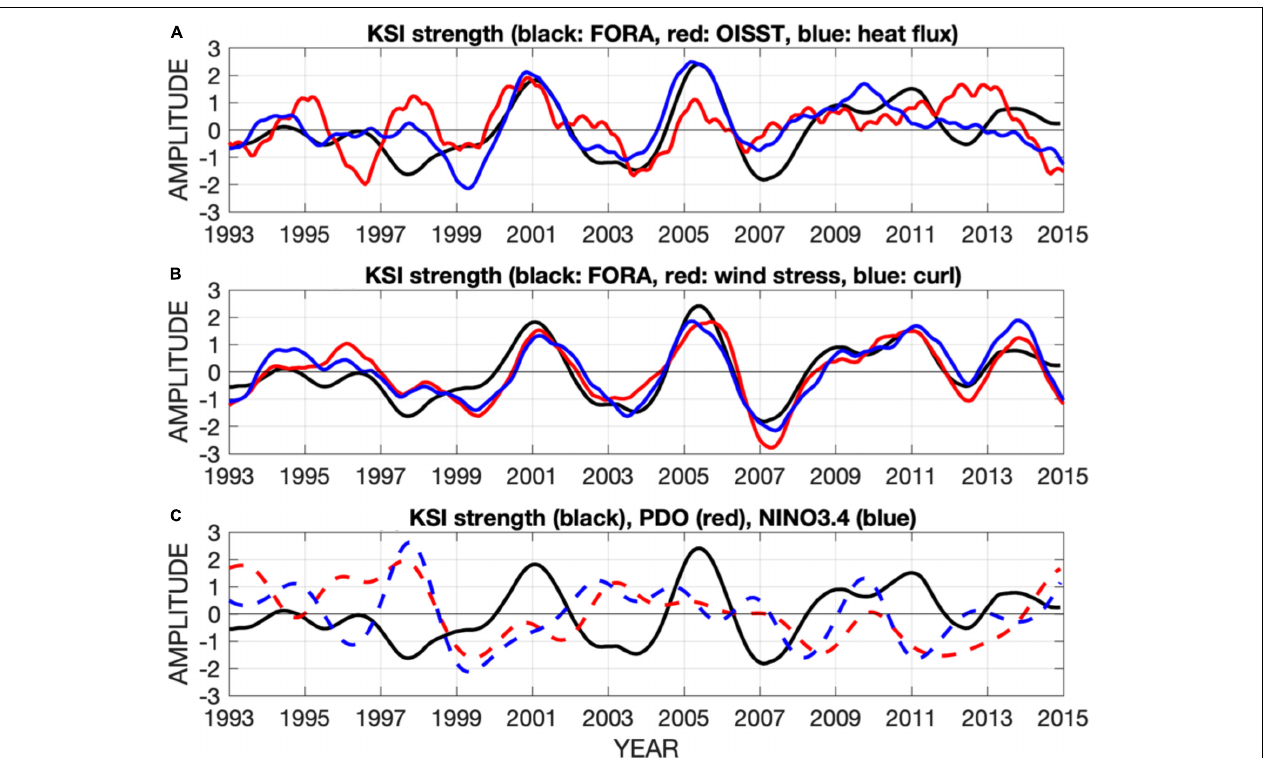
FIGURE 9 | Comparison of the temporal variability of the KSI strength mode, K _ index ( t ) (black) with (A) the regressed time series of SST (red) and surface heat flux (blue), (B) the regressed time series of wind stress (red) and wind stress curl (blue), and (C) the PDO index (red) and Niño3.4 index (blue). The PDO index and Niño3.4 index were 12-month low-pass filtered after removing seasonal climatology. The spatial pattern of the KSI strength mode is displayed in Figure 3 . The regressed anomalies of the surface ocean environmental variables over the ECS are presented in Figure 8